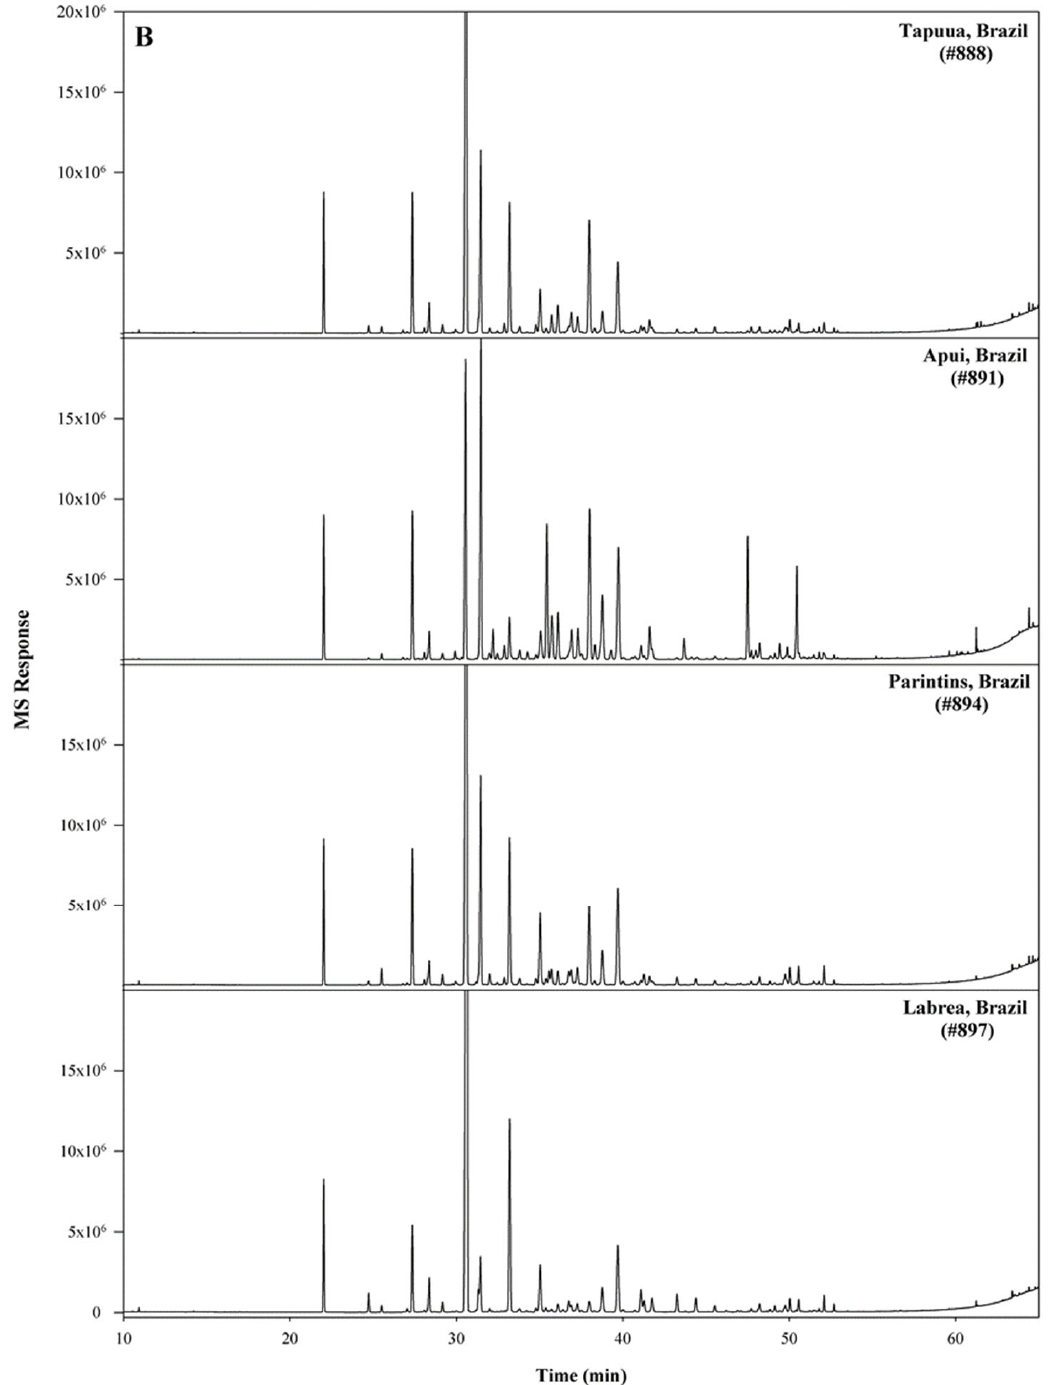
Figure 1. ( A ) Representative total ion chromatograms for: authentic (#615), unknown sample (#623), and commercial products (#862 from Peru and #874 from Ecuador). Compound identification is indicated in Table 1. ( B ) Representative total ion chromatograms for unknown samples collected from different locations in Brazil (#888, Tapuua; #891, Apui; #894, Parintins; #897, Labrea).